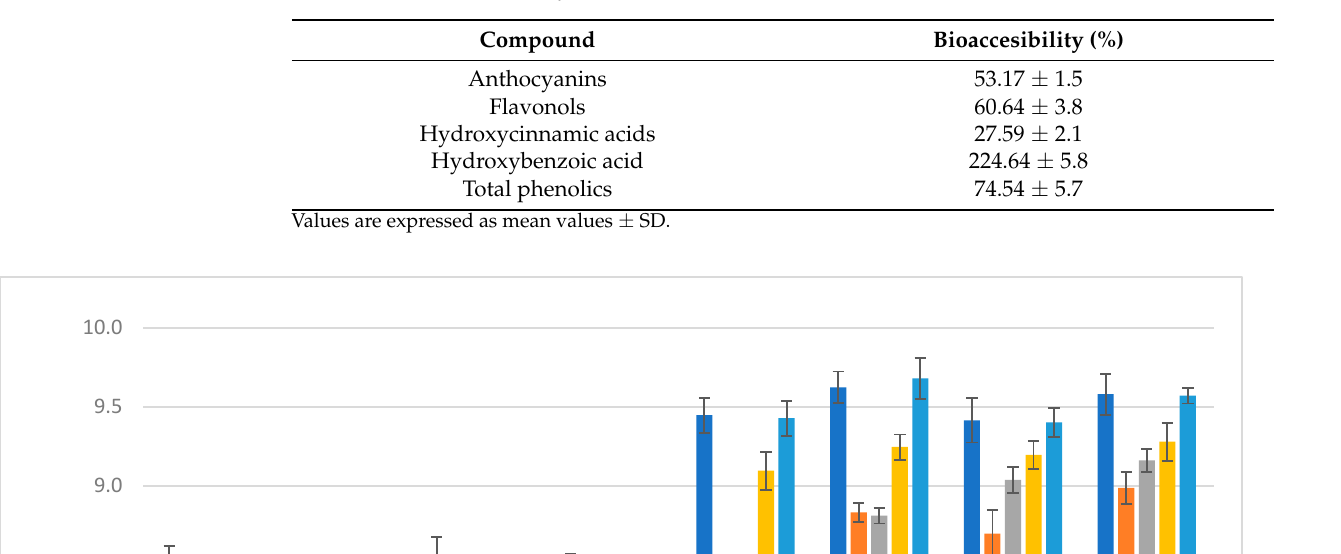
Table 4. The bioaccessibility of EB extract.